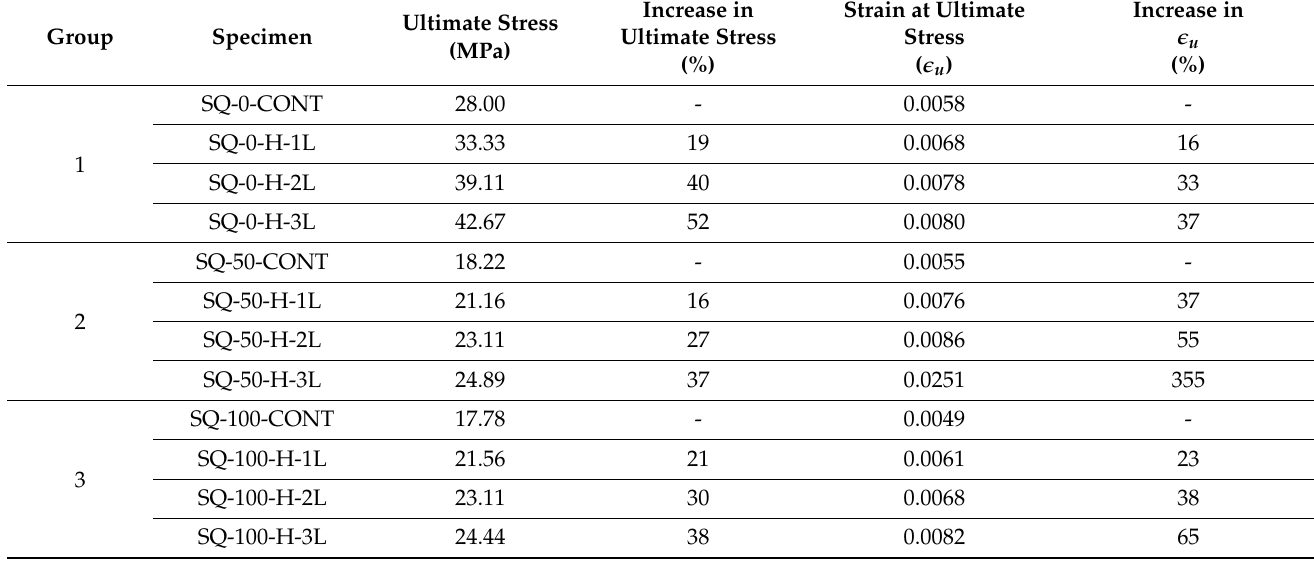
Table 3. Summary of the experimental